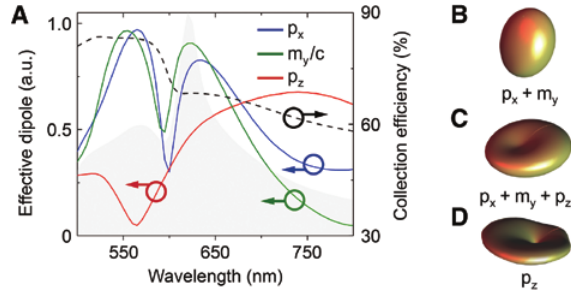
Figure 3: Multipole analysis and the far-field feature of a SiNPoM